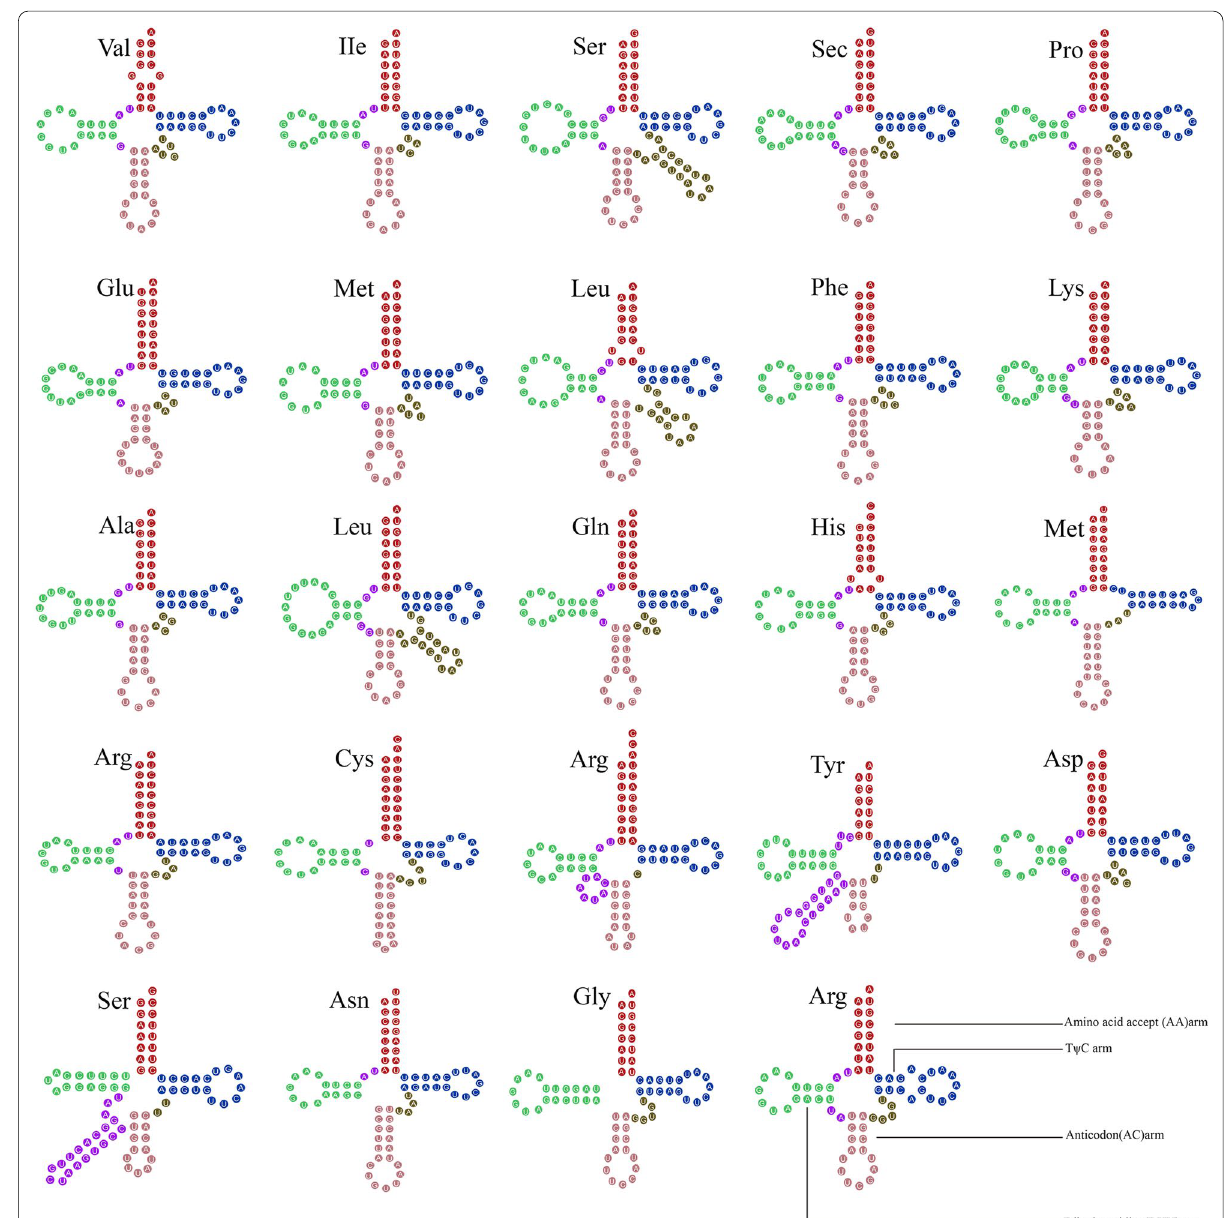
Fig. 2 Putative secondary structures of tRNAs from Ophiocordyceps gracilis mitogenomes. The amino acid accepter (AA) arm is shown in red; the TψC arm is shown in blue; the anticodon (AC) arm is shown in pink, and the dilhydoroudine (DHU) arm is shown in